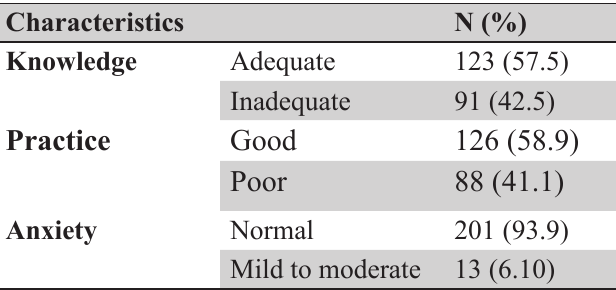
Table 3. Level of knowledge, practice and anxiety regarding COVID-19 of respondents